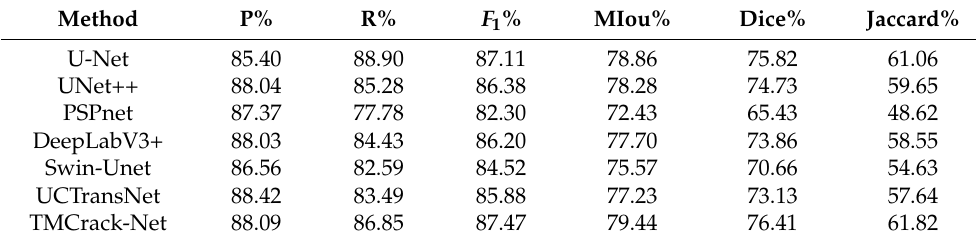
Table 6. Performances of different methods on Crack500.